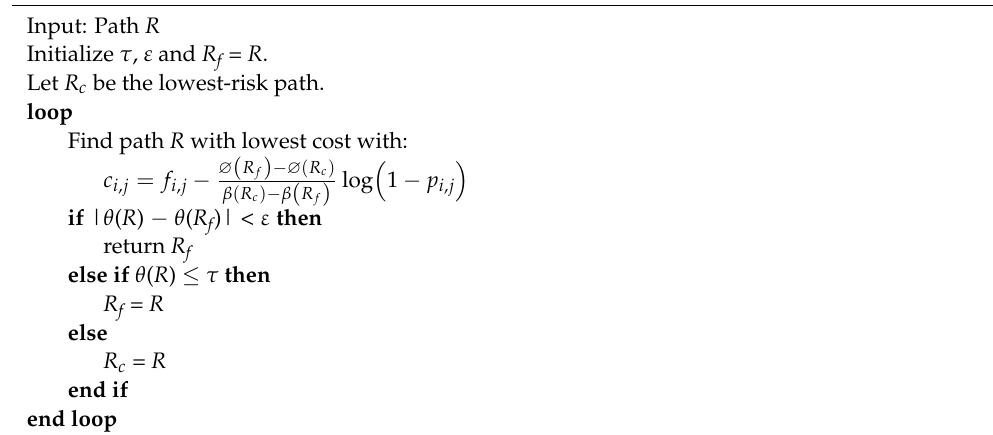
Algorithm 2: Lagrangian relaxation method, suboptimal solution to